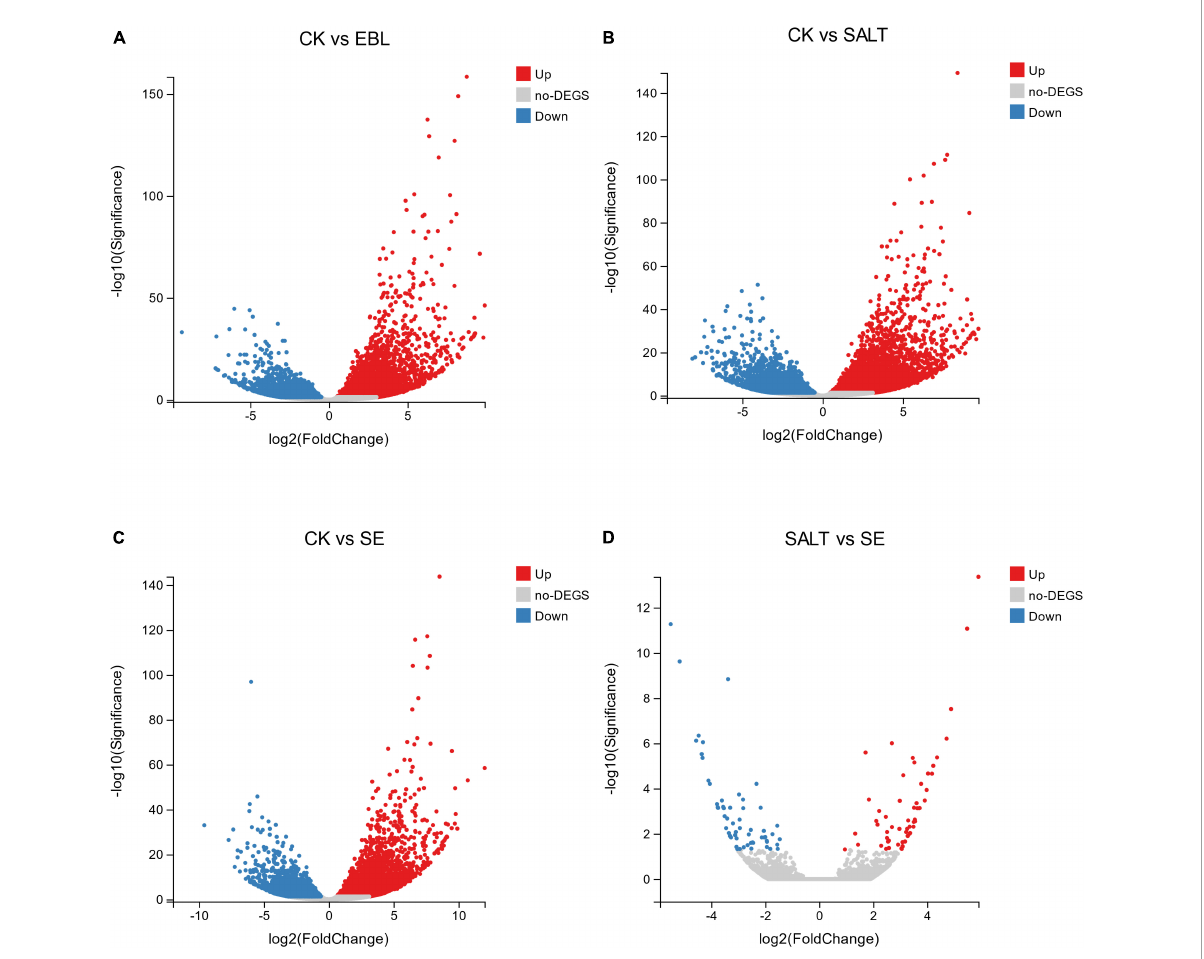
FIGURE3 Differential genes between groups in volcano maps. (A) The distribution of differential genes between CK and EBL; (B) The distribution of differential genes between CK and SALT; (C) The distribution of differential genes between CK and SE; (D) The distribution of differential genes between SALT and SE. Up-regulated genes were shown in red and down-regulated genes were shown in